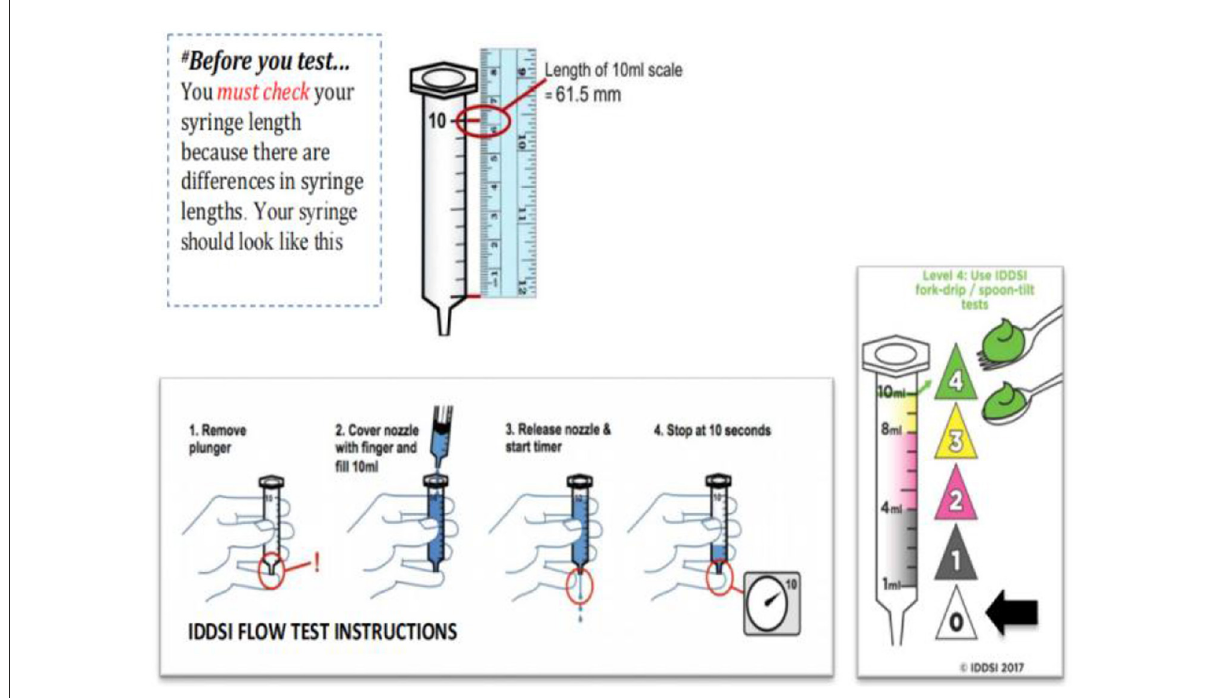
FIGURE2 The International Dysphagia Diet Standardization Initiative Flow Test Instructions. Reprinted with permission from Hind et al.